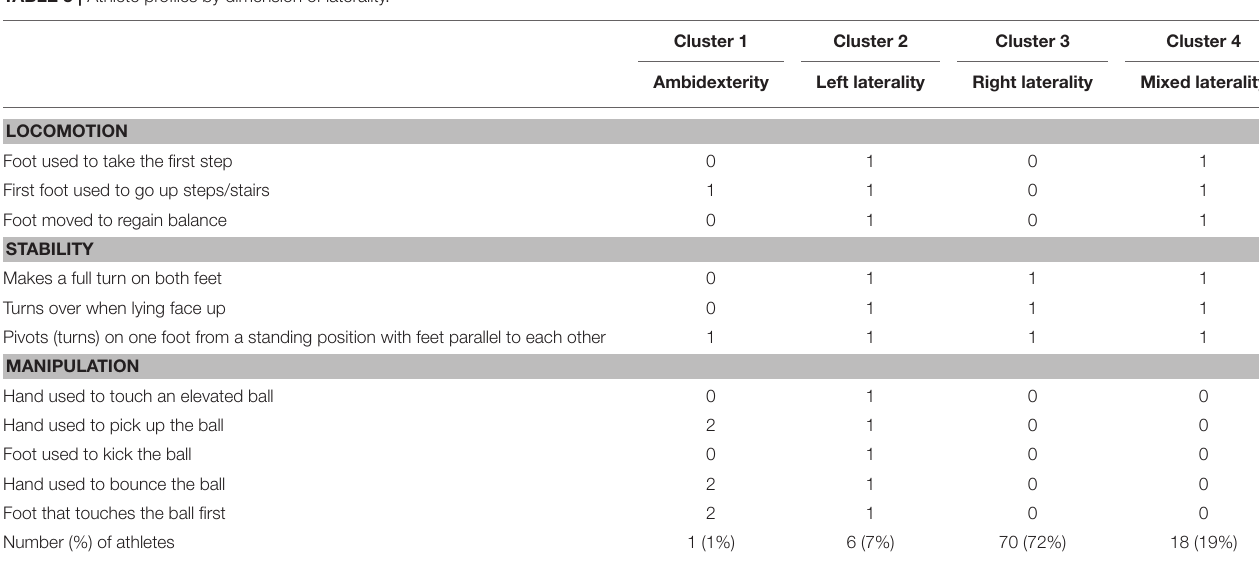
TABLE 3 | Athlete profiles by dimension of laterality.